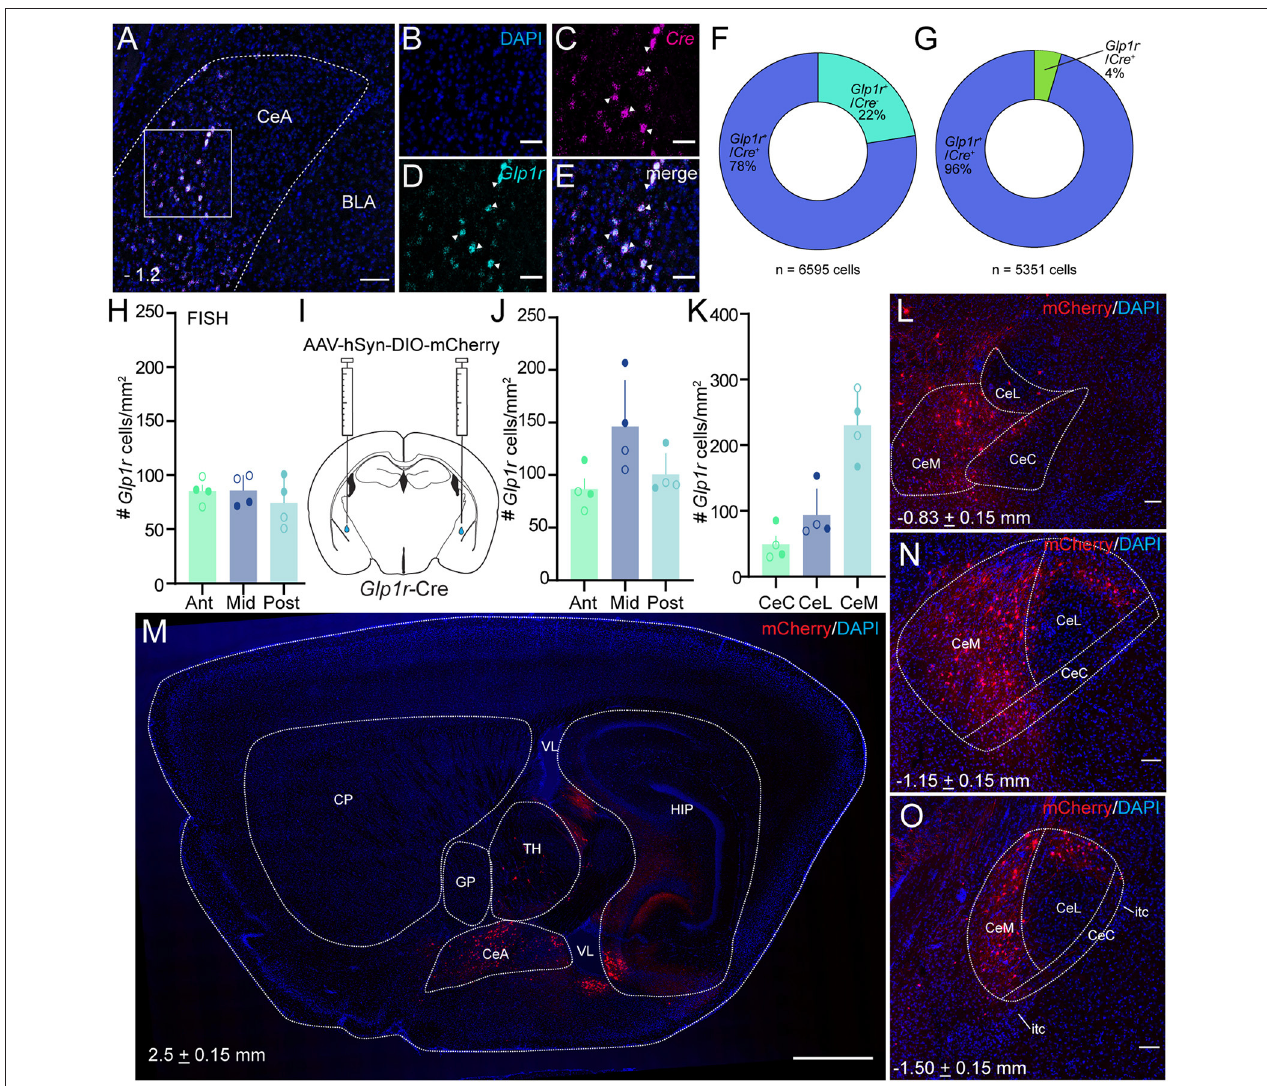
FIGURE 2 | Glp1r CeA neurons are distributed across the rostral-caudal axis and enriched in the CeM. ( A–G ) Glp1r -Cre line validation using dual florescence in situ hybridization. (A) Wide field merged view of CeA with Glp1r in cyan and Cre in magenta. Square represents enlarged, single channel view shown in (B–D) and enlarged merged view in (E) . (F) Quantification of Cre mRNA expression within Glp1r + neurons ( n = 6,595 cells, 824.4 ± 125.6s.e. cells per mouse). (G) Quantification of Glp1r mRNA expression within Cre + neurons ( n = 5,351 cells, 668.9 ± 101.3s.e. cells per mouse). Data shown in (F,G) was obtained from 8 images taken from 4 mice. (H) Schematic of CeA injection of AAV-hSyn-DIO-mCherry in Glp1r -Cre mice. (I) Quantification of FISH labeled Glp1r CeA neurons across the rostral-caudal axis (counts from 3 to 4 sections per subdivisions per mouse). (J) Quantification of virally tagged Glp1r CeA neurons across the rostral-caudal axis [ n = 4, including two male and two female wild type mice; Ordinary one-way ANOVA with Tukey’s multiple comparisons test; f = 4.190, p = 0.0520 (Ant vs. Mid), 0.7997 (Ant vs. Post) and 0.1402 (Mid vs. Post)]. (K) Quantification of Glp1r CeA neurons at different subdivisions of CeA [ n = 4, including two male and two female wild type mice; Ordinary one-way ANOVA with Tukey’s multiple comparisons test; f = 21.89, p = 0.3125 (CeC vs. CeL), 0.0004 (CeC vs. CeM) and 0.0025 (CeL vs. CeM)]. For (H–K) , open circles represent data obtained from female mice and closed circles represent data obtained from male mice. (L,N,O) Example coronal images of Glp1r CeA distribution in anterior (L) , middle (N) and posterior (O) segments of the CeA. (M) Example sagittal image of Glp1r CeA distribution. Note some viral tagging of putative Glp1r neurons outside the CeA. Scale bars represent 100 µ m (A,M) or 50 µ m (B–E) . For all experiments, * p < 0.05, ** p < 0.01, and *** p < 0.001. CP, caudoputamen; GP, globus pallidus; TH, thalamus; VL, lateral ventricle; HIP, hippocampal region.